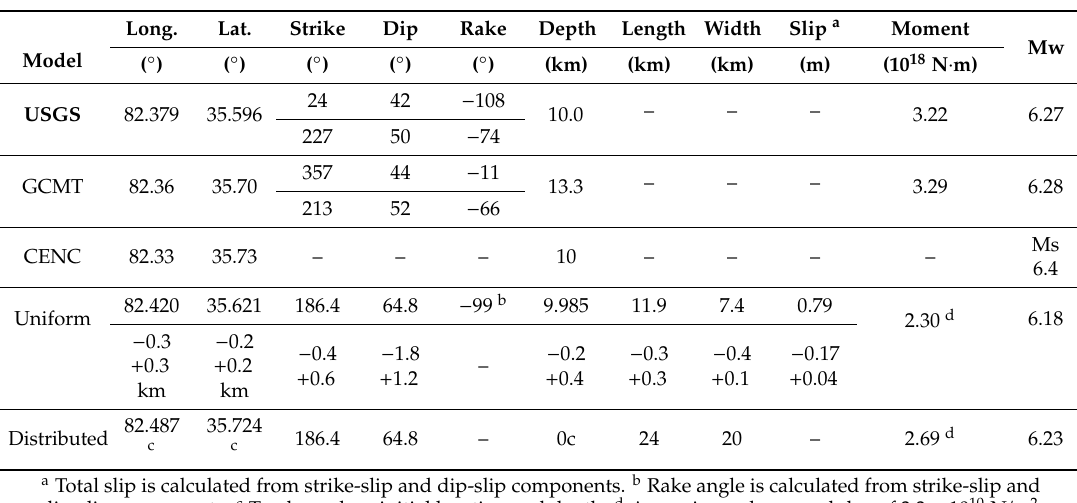
Table 3. Source parameters of the 2020 Yutian earthquake.